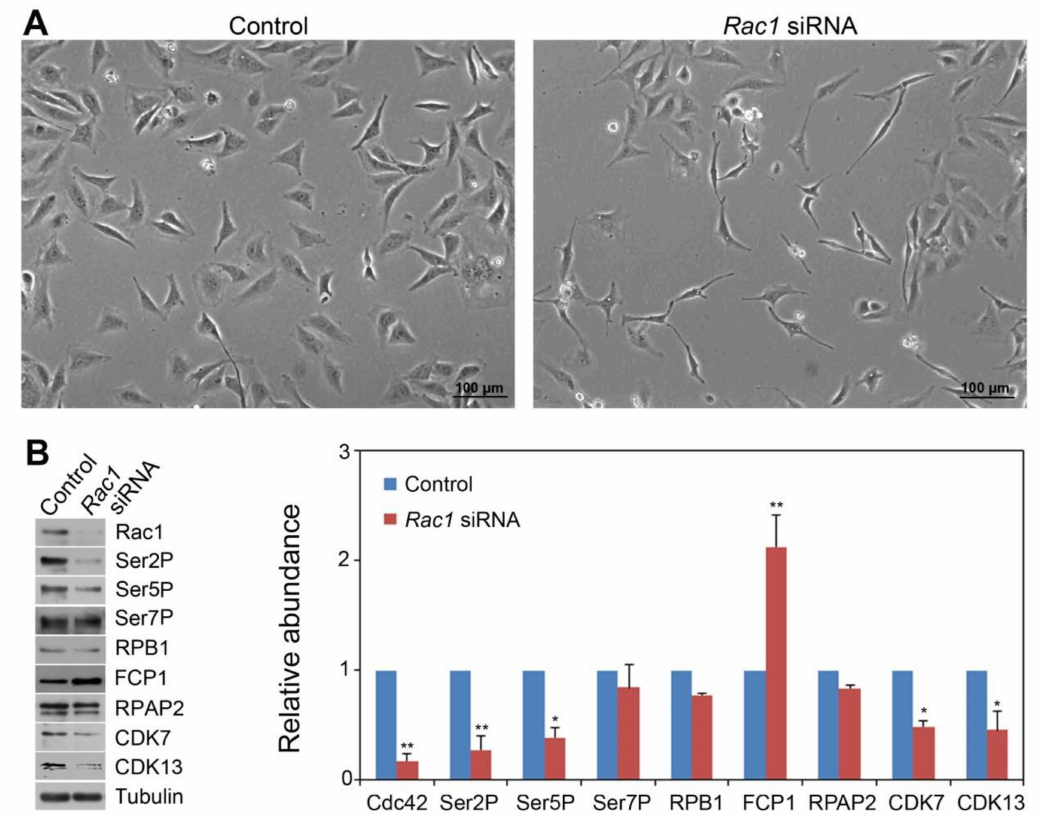
Figure 3. siRNA-based Rac1 knockdown modulated the CTD phosphorylation code and a ff ected the level of CTD phosphatases and kinases in Hela cells. ( A ) HeLa cells 48 hr after Rac1 siRNA transfection. ( B ) Western blot showing the levels of Cdc42, Ser2P, Ser5P, Ser7P, FCP1, RPAP2, CDK7 and CDK13 in Rac1 siRNA-transfected HeLa cells. Tubulin, the protein loading control. Quantitative analysis of the Western blot results from two independent biological replicates was shown. Protein level in the control was set as 1.0. Significance level is indicated by * ( p < 0.05) or ** ( p < 0.01) vs.